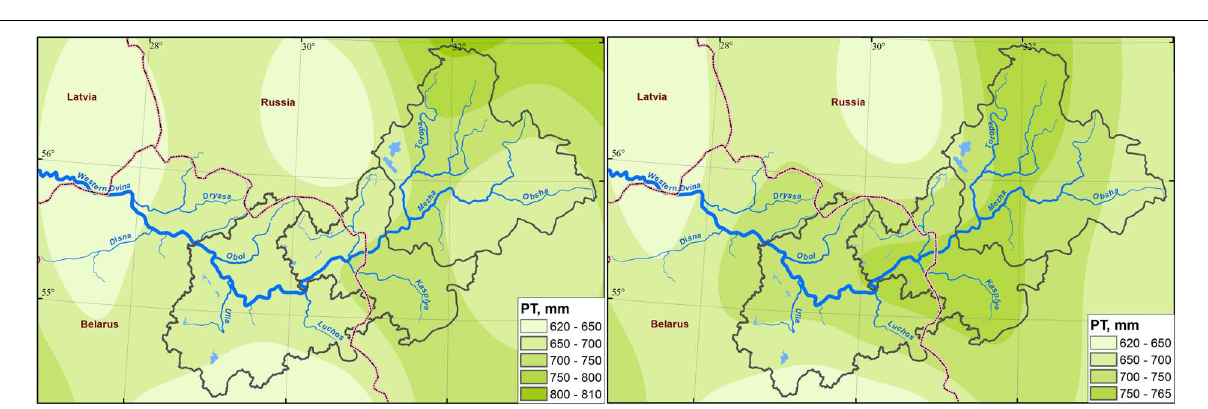
increased by up to + 1 o C and the largest increase (by up to + 1.5 – + 2.5 ◦ C) was documented in the winter